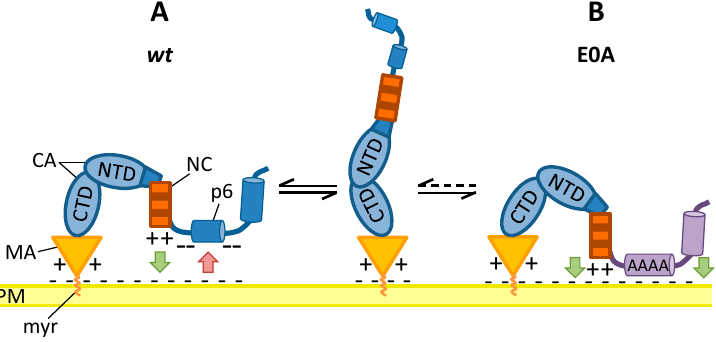
Figure 10. Hypothetical model of regulation of Gag membrane interaction. Green arrows indicate attraction, red arrows indicate repulsion. CTD: C-terminal domain; NTD: N-terminal domain; PM: plasma membrane.